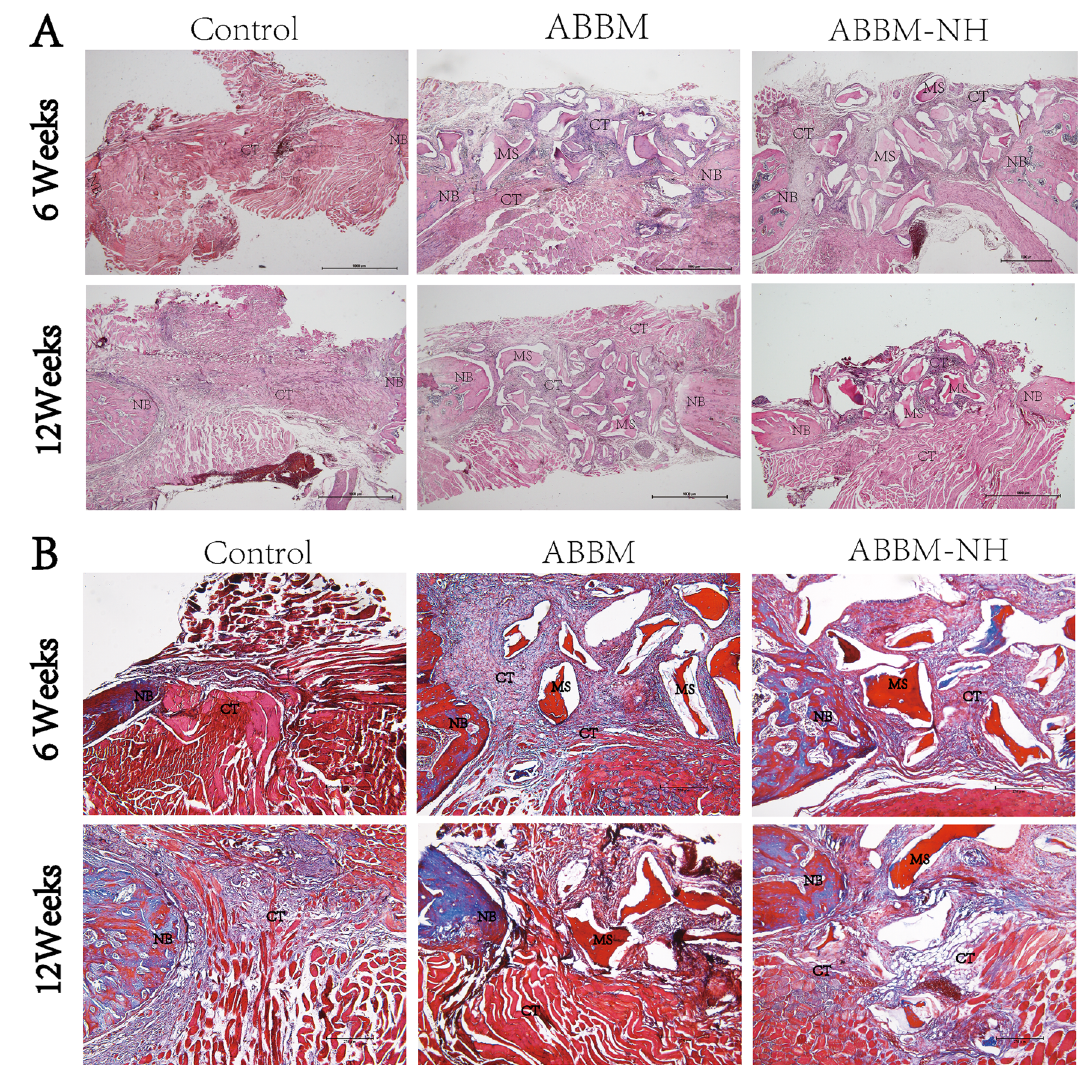
Fig. 6 The histology observed at 6 weeks and 12 weeks after the operation. A HE staining ( n = 5); ( B ) Masson staining ( n =